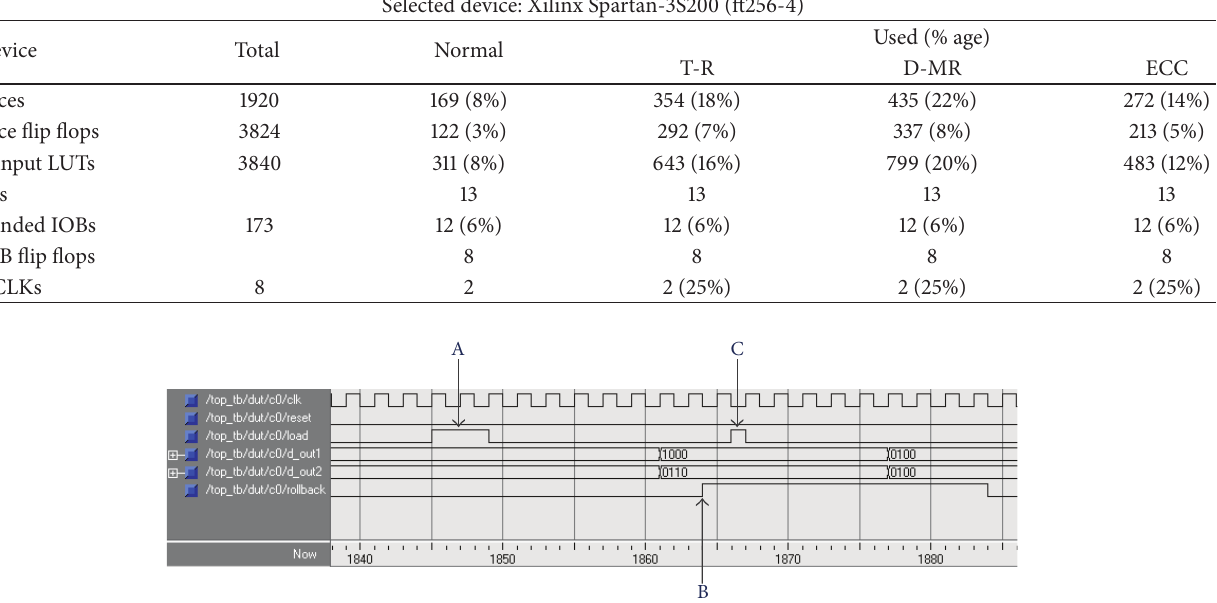
Figure 4: Fault detection and correction in DMR.